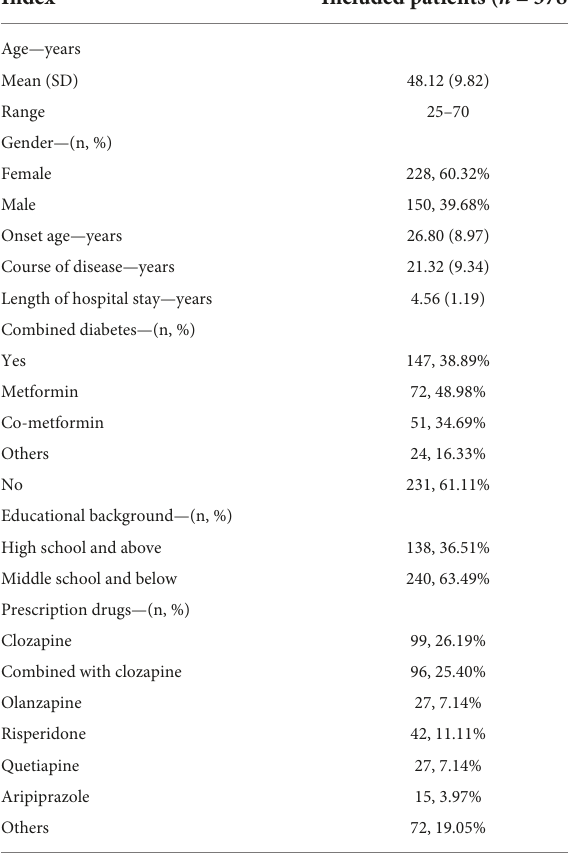
TABLE 1 The general clinical characteristics of the included